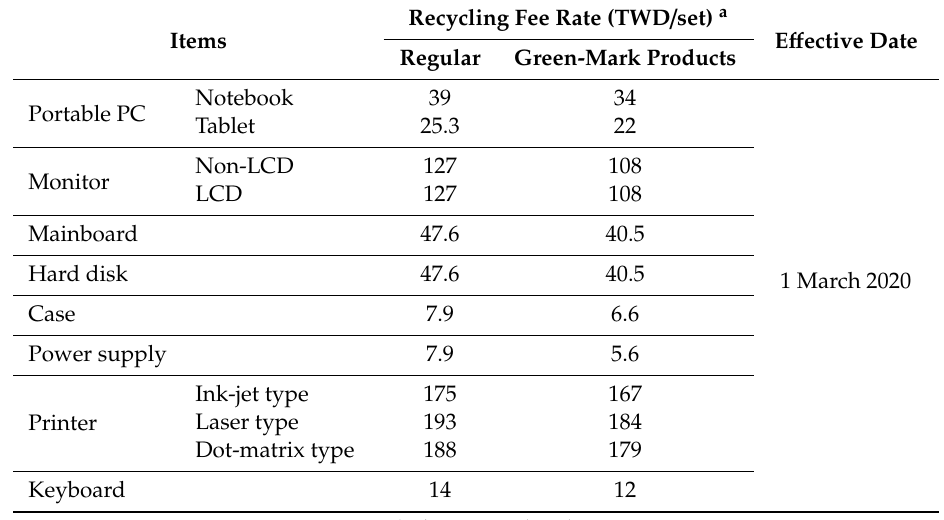
Table 2. Current recycling fee rates of recyclable IT products in Taiwan.